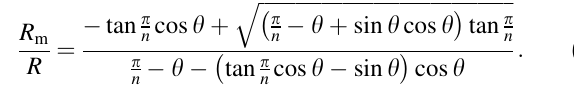
Fig. 3 Cross section of the single-corner capillary with the contact angle,